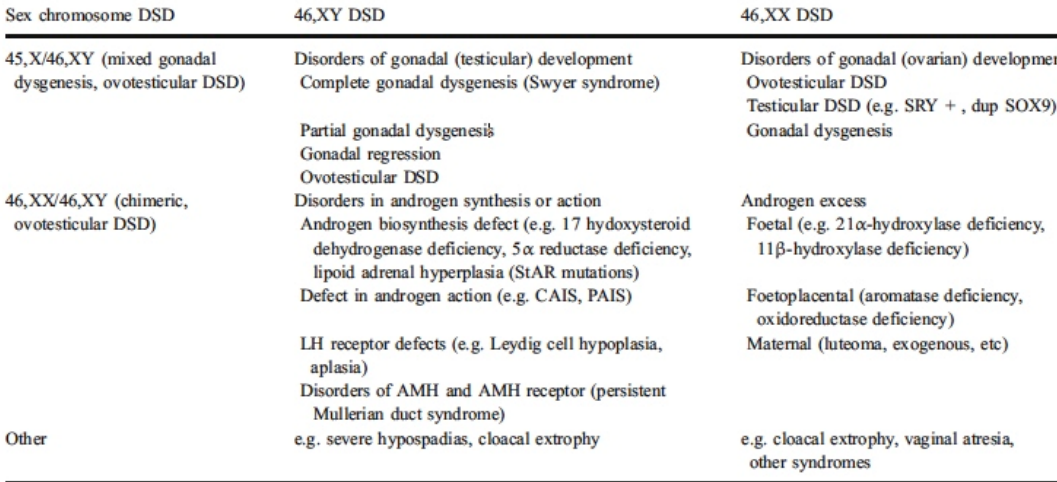
Figure 1. Example classification for ‘disorders of sex development’ [23].